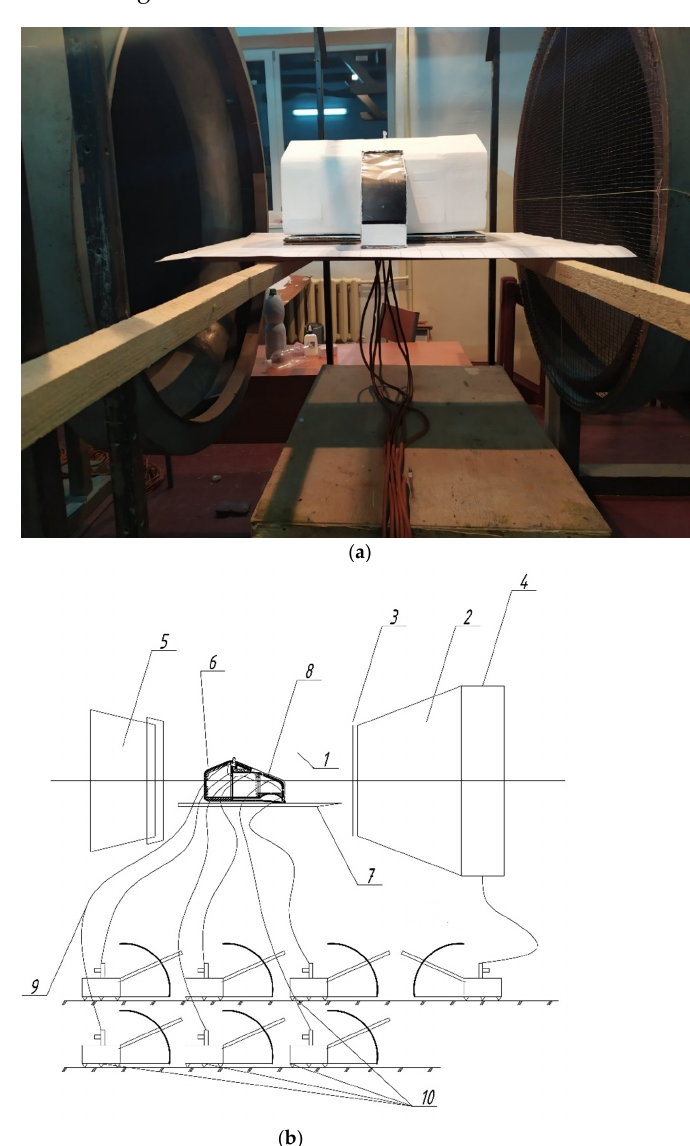
Figure 1. Photo of a model of a modular house in the working part wind tunnel: ( a ) scheme of experimental setup; ( b ) 1—working part of the wind tunnel; 2—nozzle; 3—leveling grid; 4—prechamber; 5—diffuser; 6—model of the house; 7—underlying surface of the model; 8—drainage points (static pressure selection); 9—flexible tubes; 10—micromanometers MMN.